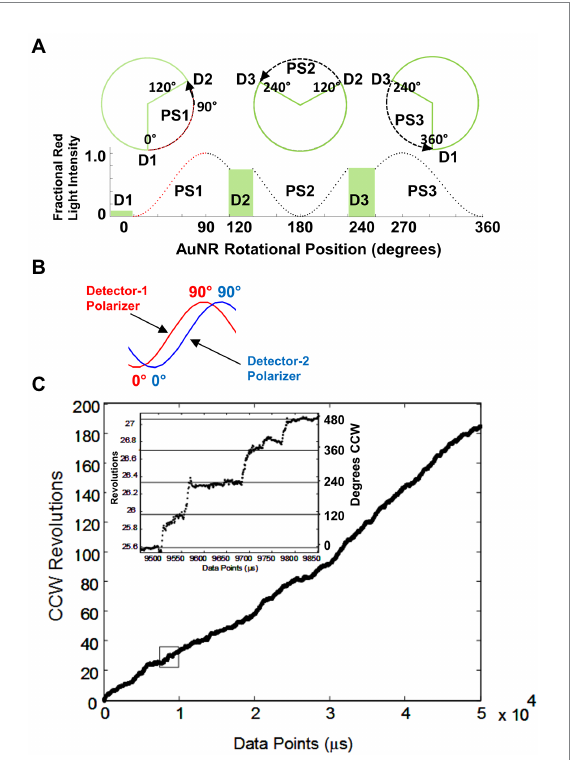
FIGURE 7 (A) Changes in AuNR scattered red light intensity during one complete revolution involving three consecutive power strokes (PS) and three consecutive catalytic dwells (D) separated by exactly 120 ° when, prior to data collection, the polarizer is rotated such that scattered light intensity is at a minimum during catalytic dwell-1 (D1). (B) Rotational off-set of polarizer positions when two detectors are used to observe the direction of rotation. (C) Counterclockwise rotation observed by Ec F 1 - ATPase-dependent rotation calculated from two detectors with off-set polarizer positions with data acquired at 10 kHz in the presence of 1 mM MgCl 2 and 2 mM ATP. (Inset) Detail of the rotational stepping of the boxed region. Horizontal lines show the 120 ° dwell positions. This figure was reconfigured from Spetzler et al.